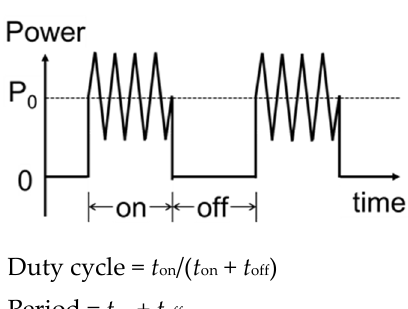
Figure 2. Time modulated RF source and the definition of duty cycle and of period.